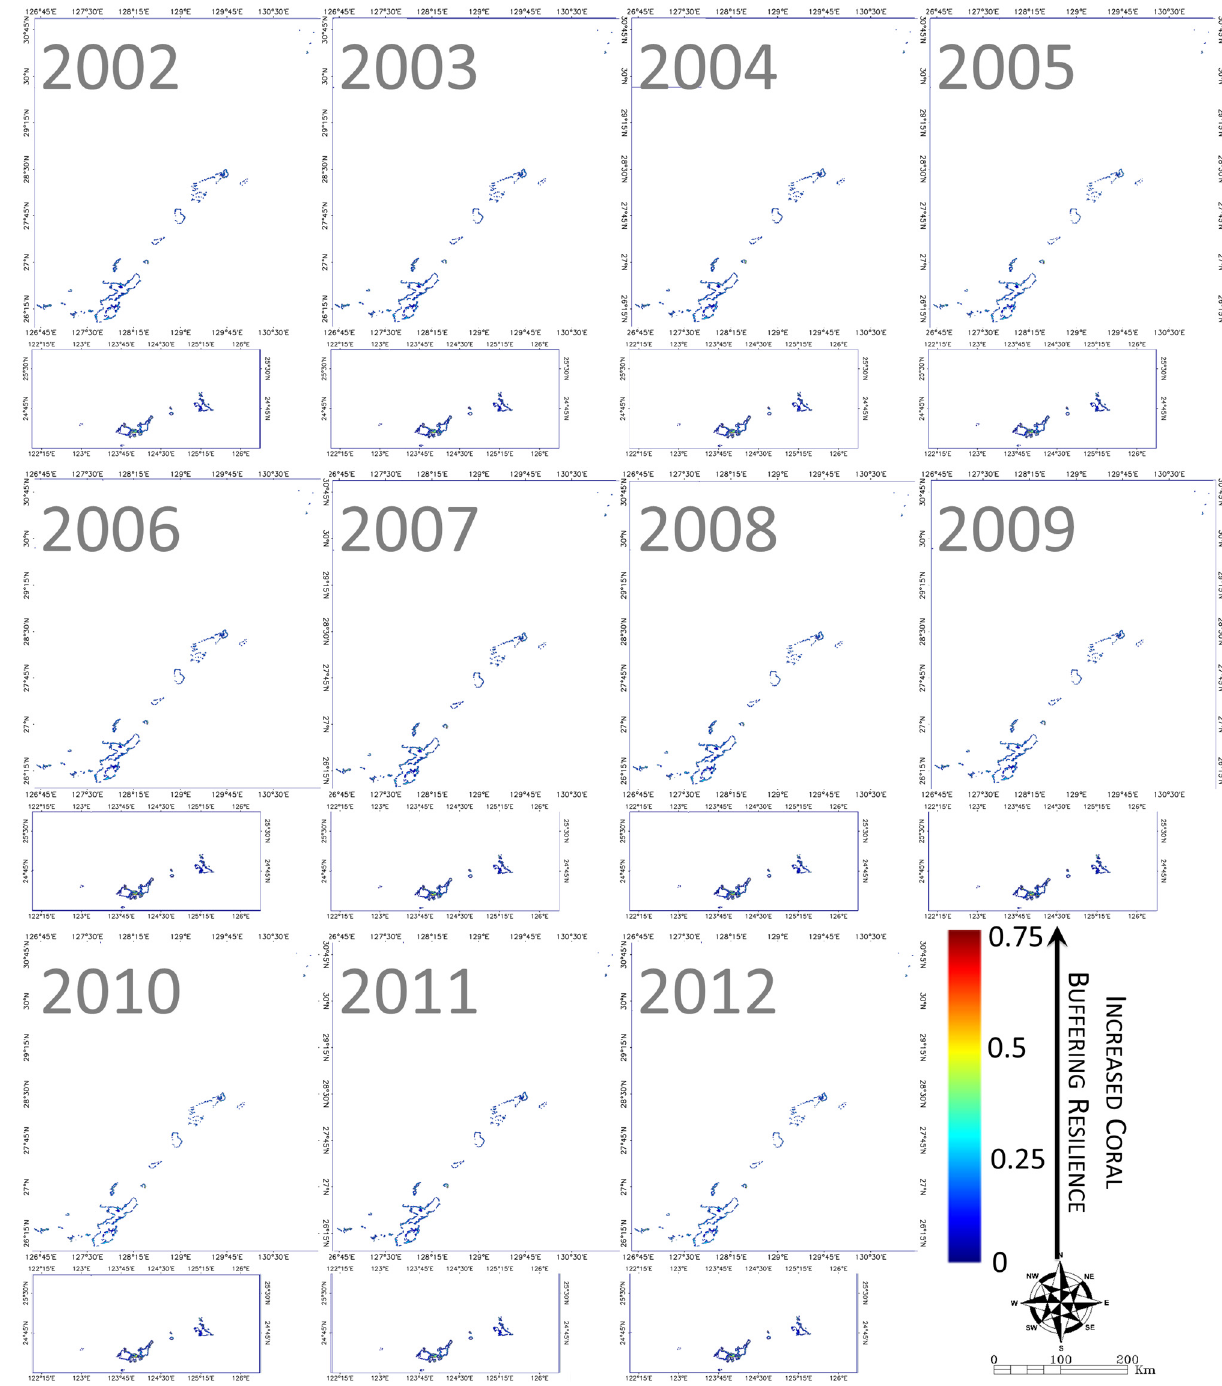
Figure 6. Nansei maps of coral buffering resilience during 2002–2012. The resilience index was based on a suite of combined thermal, sediment, urbanization, fishery, algal, emersion stressors; and connectivity, coral-source, habitat-sink, ecological-niche, cooling, coral-sink protection mitigators using a fuzzy logic approach. For each year, the investigation of the Nansei region focused on the northern and southern regions (see the two study areas in Figure